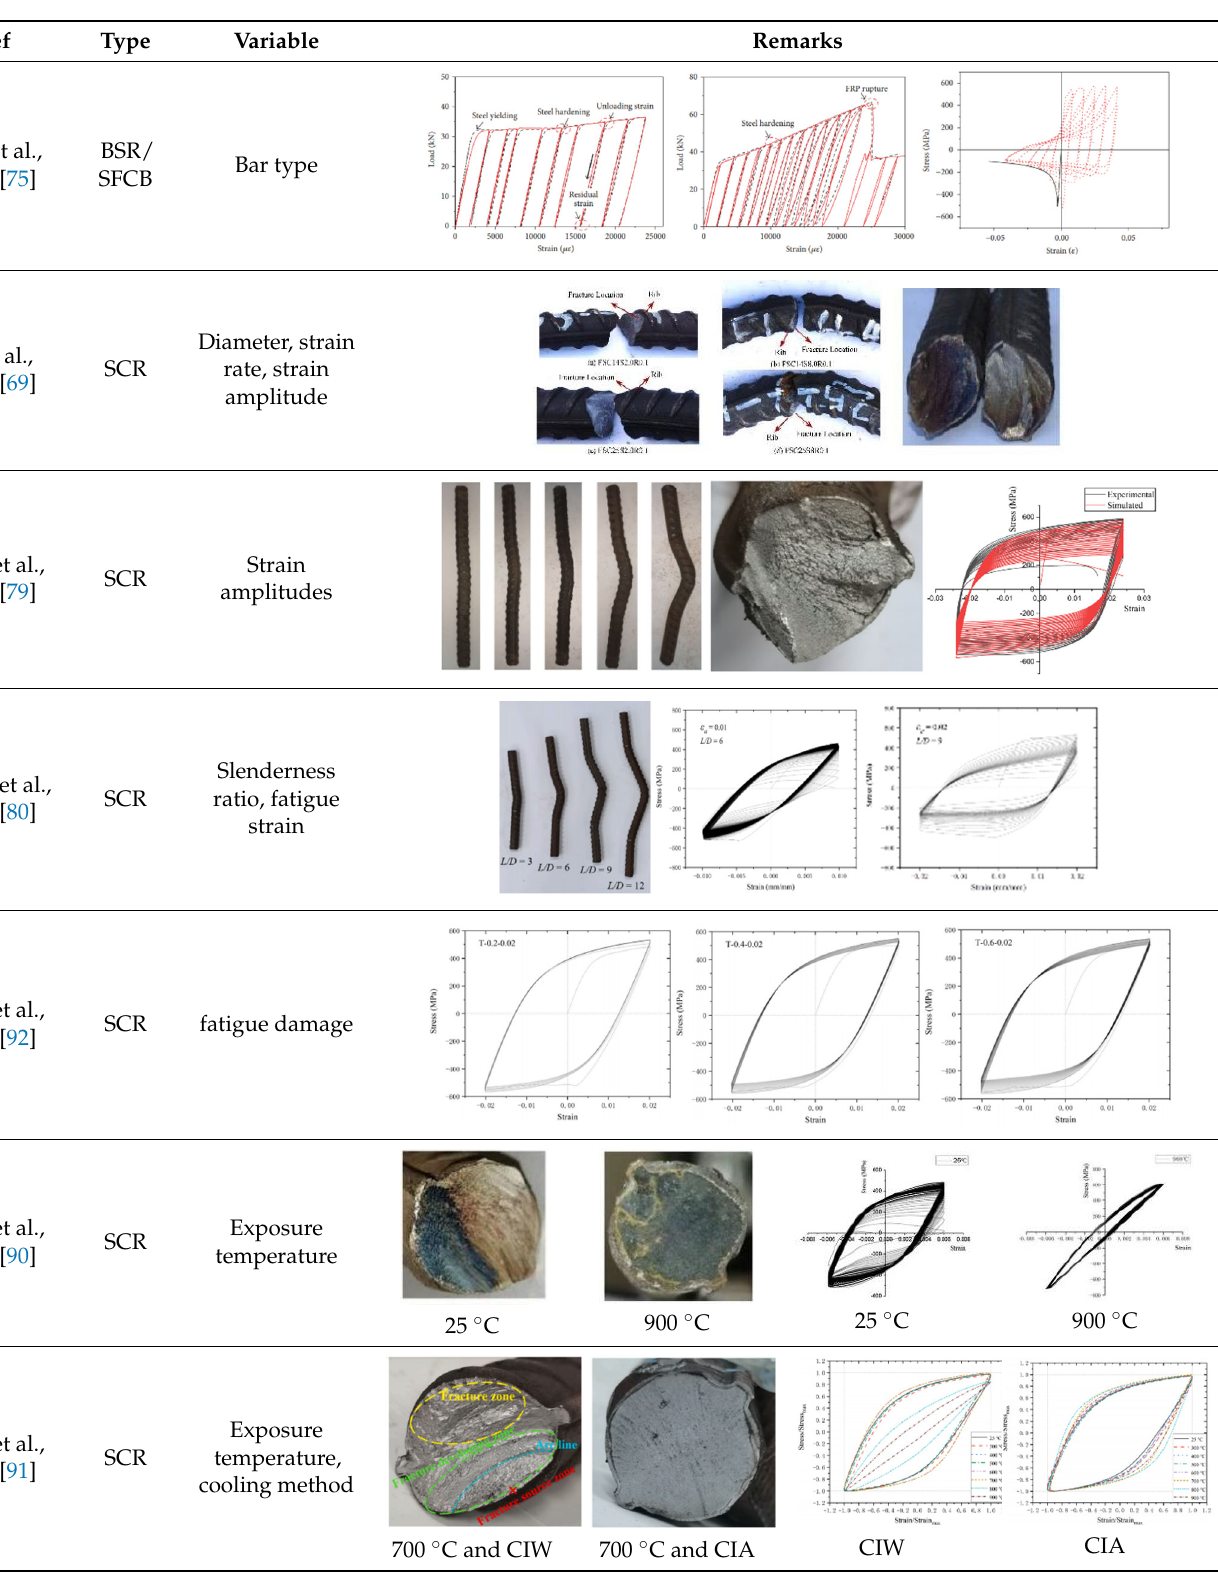
Table 3. Experiments on fatigue properties.